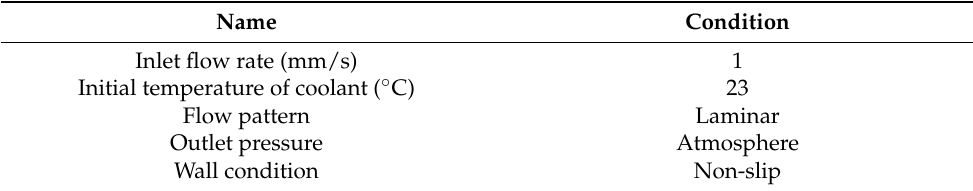
Table 8. Boundary conditions and initial conditions.